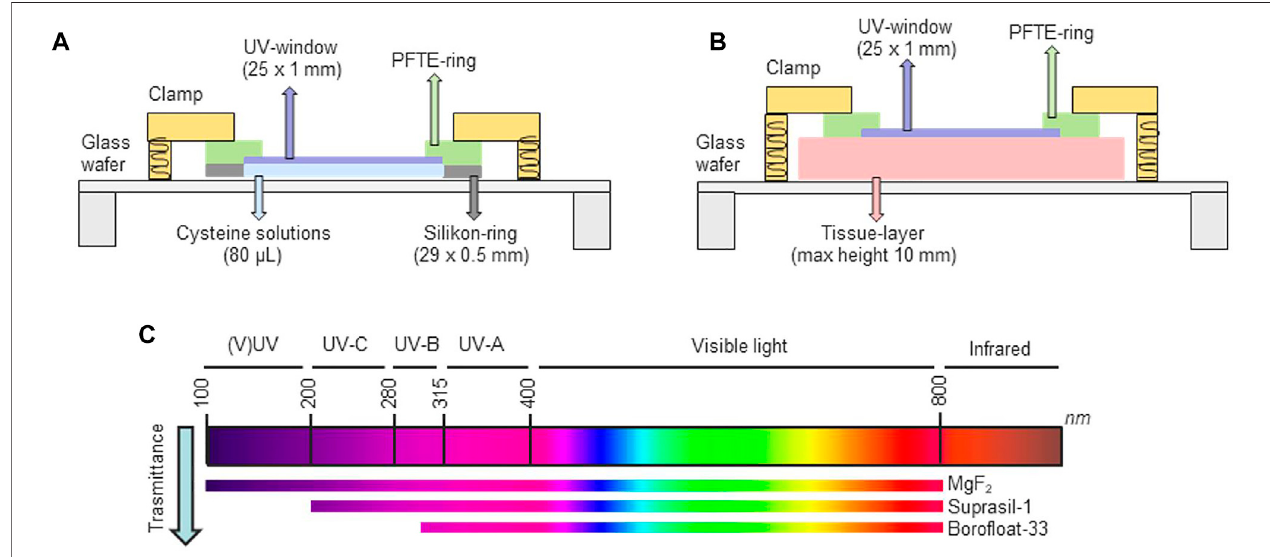
FIGURE1| Micro-chamber used toapplyUVradiationemitted kINPenplasmas (A,B) .Cysteinesolutions (A) or porcineskin sections (B) wereintroducedintothe chamber. The light transmission of the three windows is indicated in (C) .